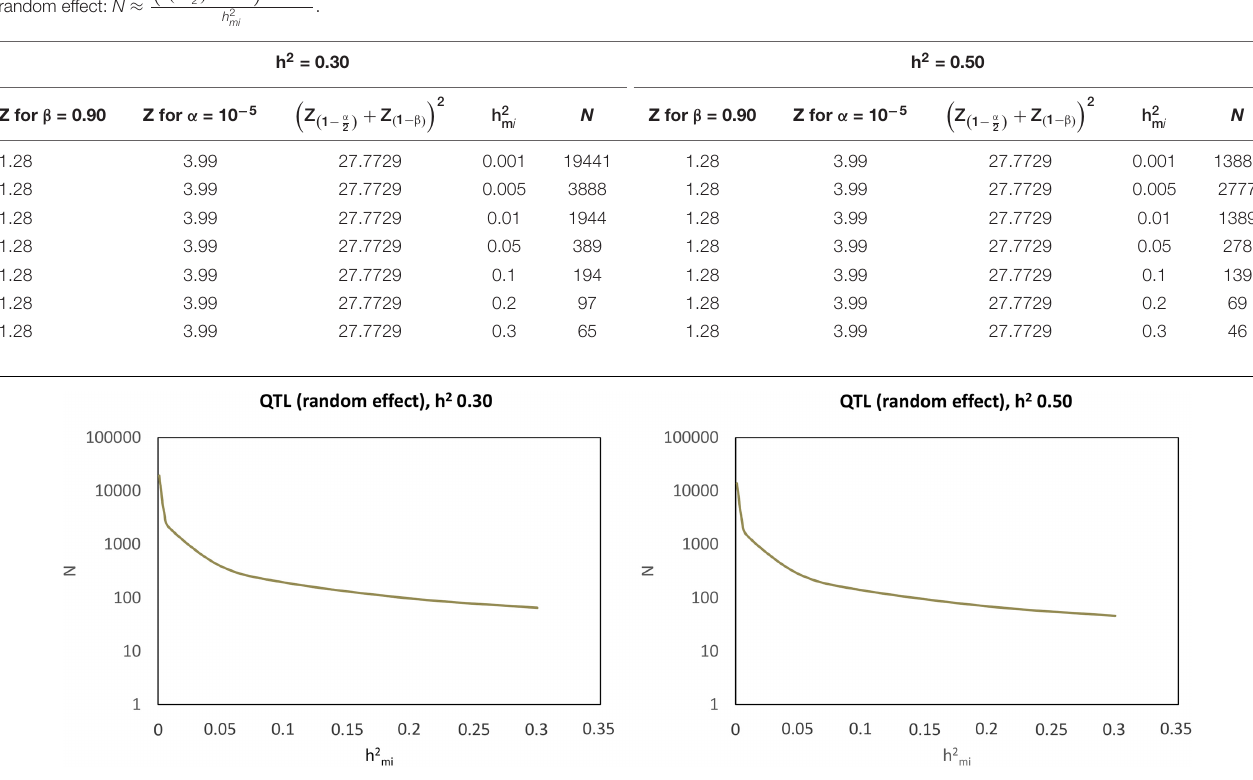
FIGURE 7 | Sample size (N) required to detect genetic effects of markers (assumed to be random effects) with different marker heritability (h 2 mi ) and total heritability (h 2 ): N values as a function of h 2 mi . The plotted N values were obtained via logarithmic transformation to improve visualization.